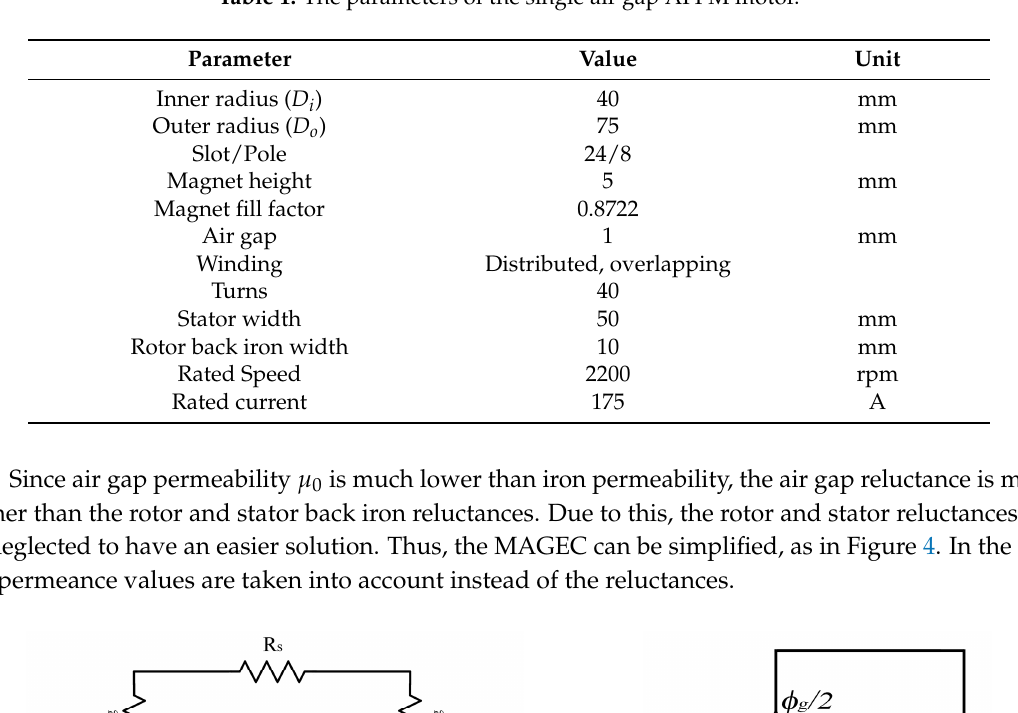
Table 1. The parameters of the single air gap AFPM motor.